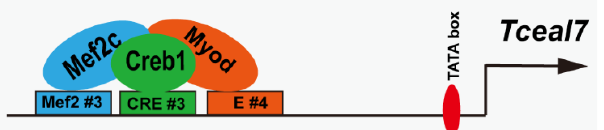
Figure 6. The model of transcriptional regulation of Tceal7 in skeletal muscle. Mef2c, Creb1 and Myod form a triple complex and bind to the distal cluster region (Mef2#3, CRE#3 and E#4), thereby transactivating Tceal7 gene expression.